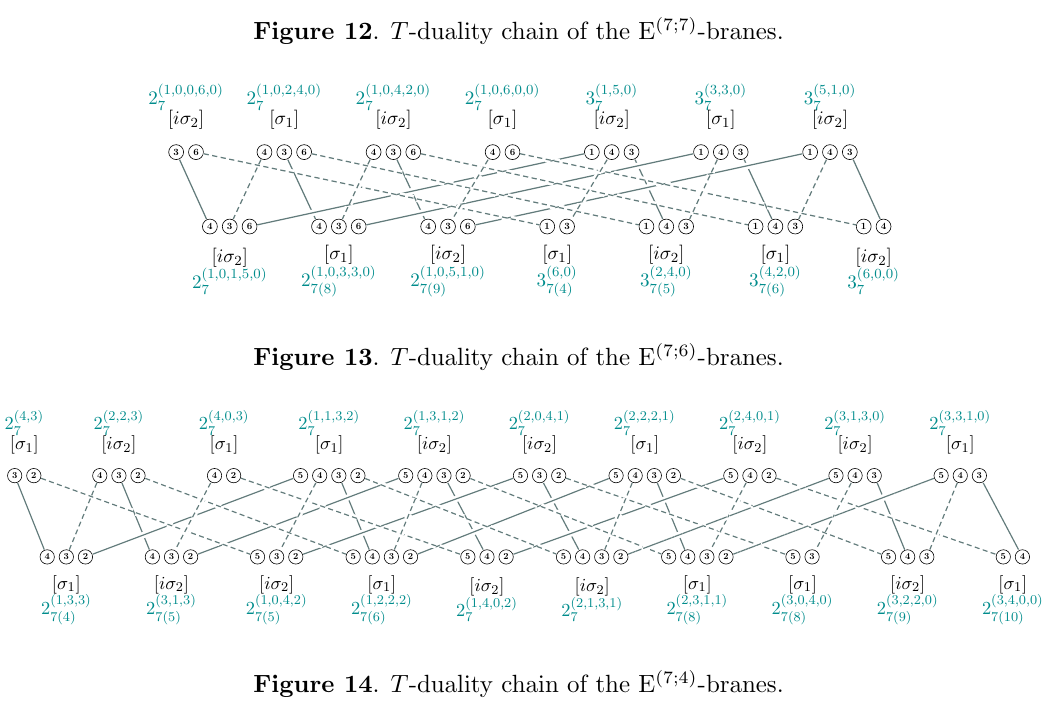
Figure 15 . T -duality chain of the E (8;7)